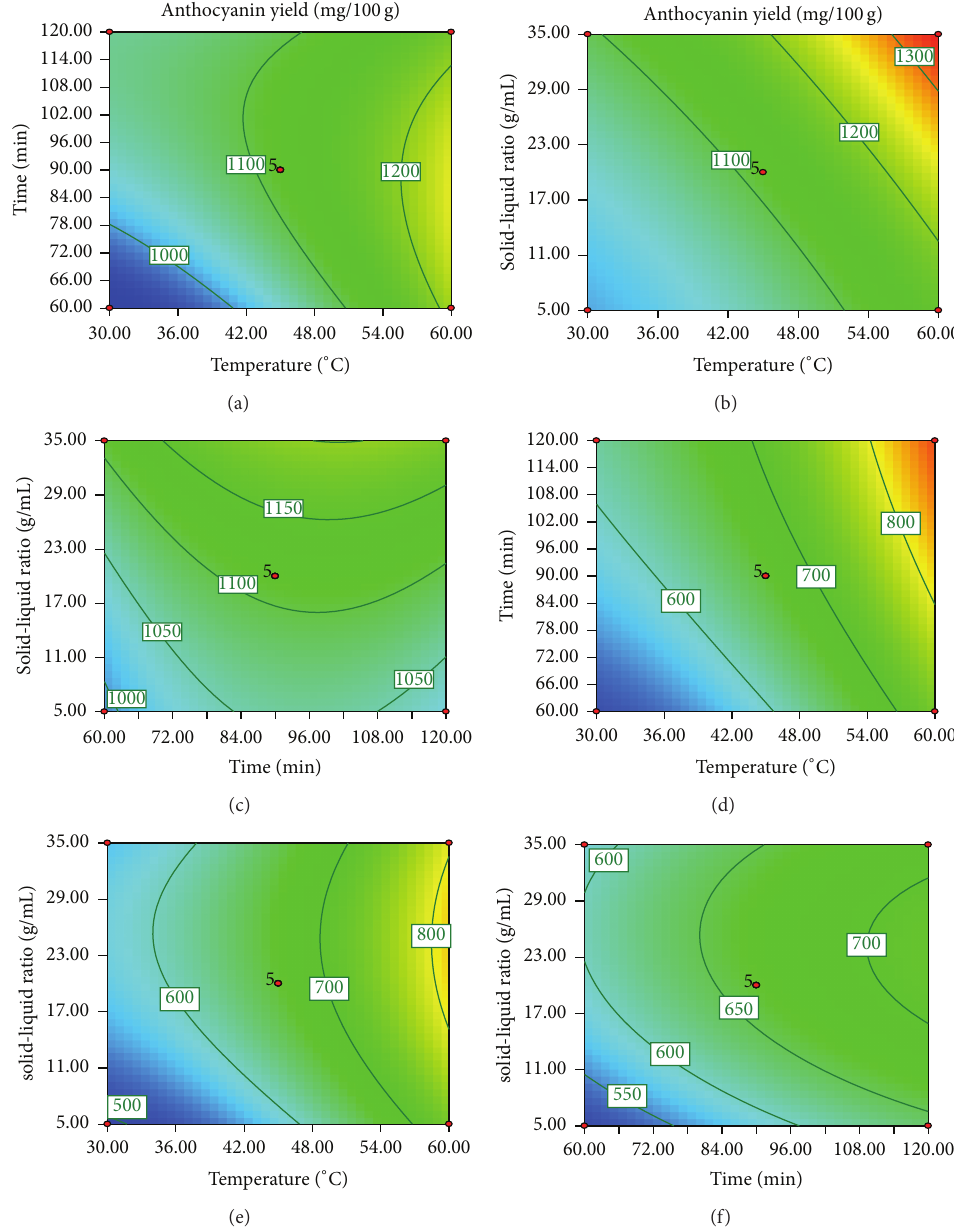
Figure 2: Contour plot showing the effects of variables for (a–c) methanolic extraction and (d-f) ethanolic